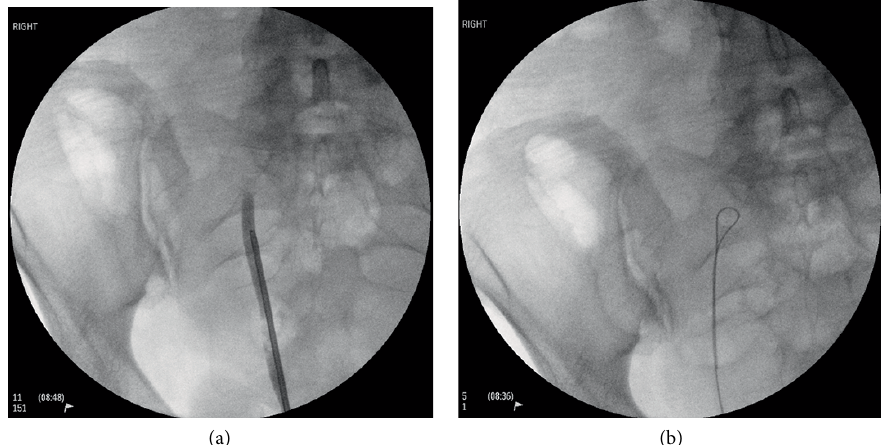
Figure 4: Right retrograde pyelogram showing a blind-ending right ureter at the level of the pelvic brim (a), where a wire could not be passed through the obstruction